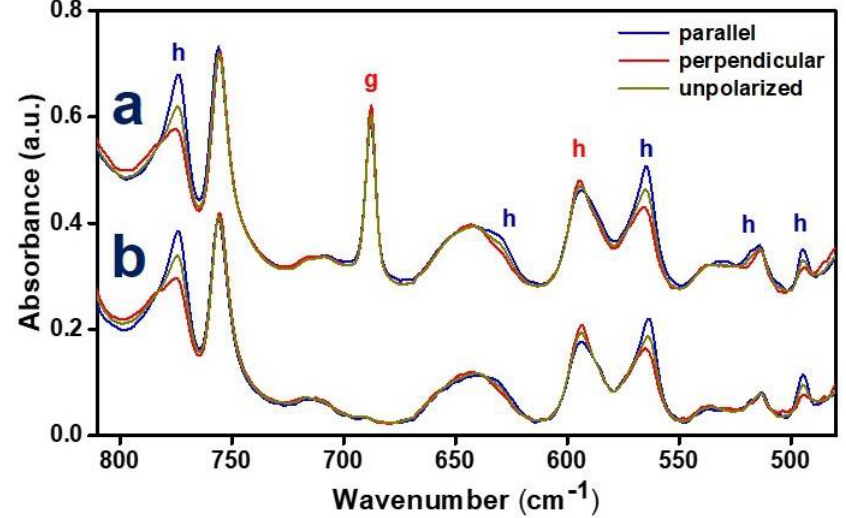
Figure 5. Polarized FTIR spectra of axial stretched PPO co-crystalline film at 175 °C up to a draw ratio of 3, ( a ) before and ( b ) after removal of the mesitylene guest by acetonitrile sorption/desorption.